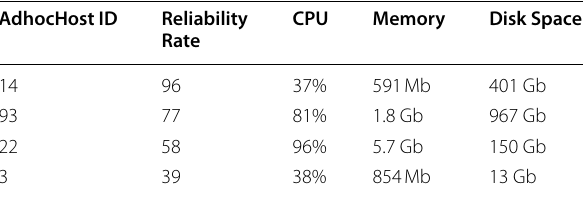
Table 2 An example for individual ‘Candidate List’ in ’Ad‑hoc Scheduler’